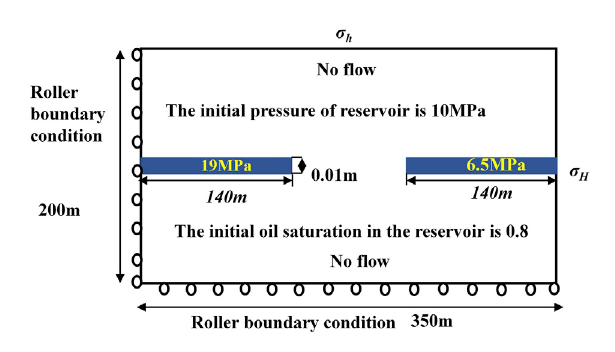
FIGURE 3 Geometry and initial boundary conditions of the numerical